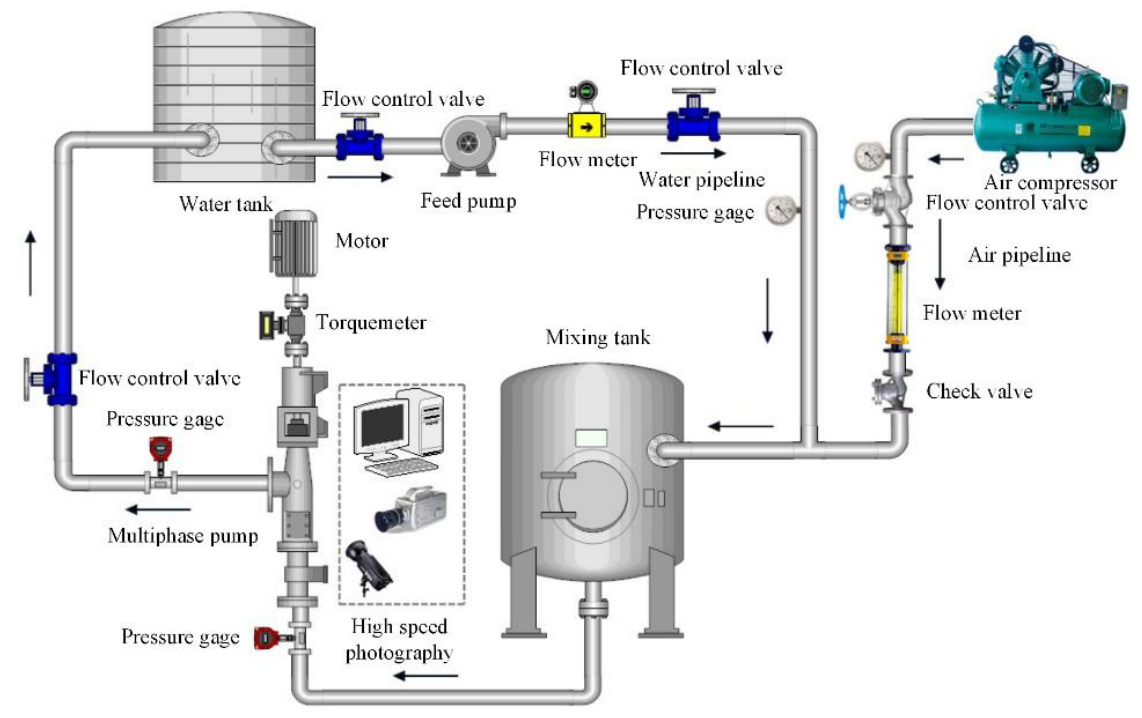
Figure 2. Helico-axial flow pump test rig.